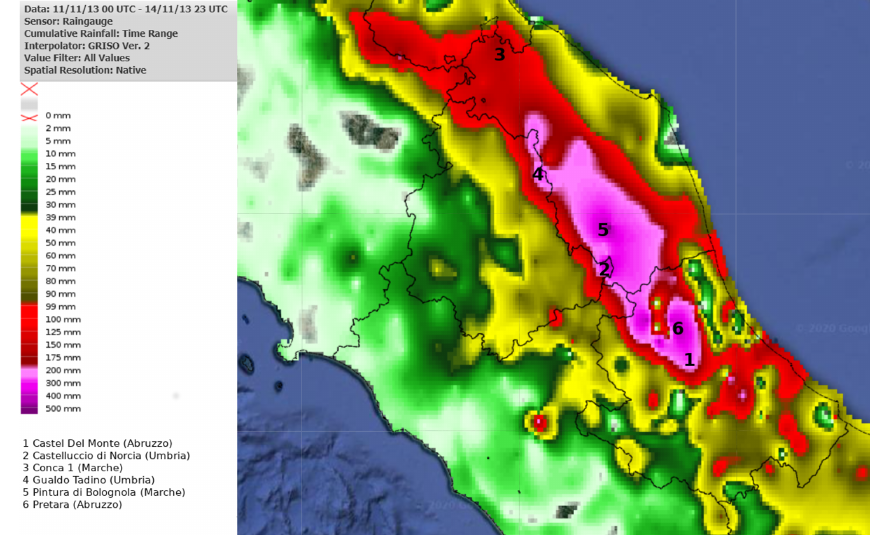
Figure 7. Total accumulated rainfall (spatialization from rain gauge official network) during the event, from 11 November 2012 00:00UTC to 13 November 2013 23:00UTC (picture generated from the Dewetra Platform, Italian Civil Protection Department and CIMA Research Foundation, 2014). The localization of the six rain gauges are indicated on the map: (1) Castel del Monte station (Abruzzo region), (2) Castelluccio di Norcia station (Umbria region), (3) Conca 1 station (Marche region), (4) Gualdo Tadino station (Umbria region), (5) Pintura di Bolognola station (Marche region), (6) Pretara station (Abruzzo region). The rain gauges recorded significant accumulated rain (up to 400mm/72h, purple